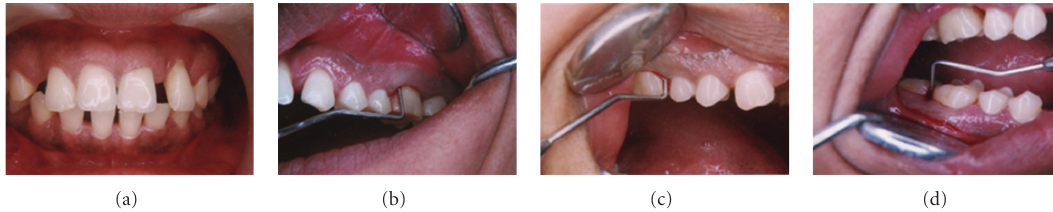
Figure 5: (a)–(d) Deep pockets were present even though signs of gingival inflammation other than bleeding on probing were absent.